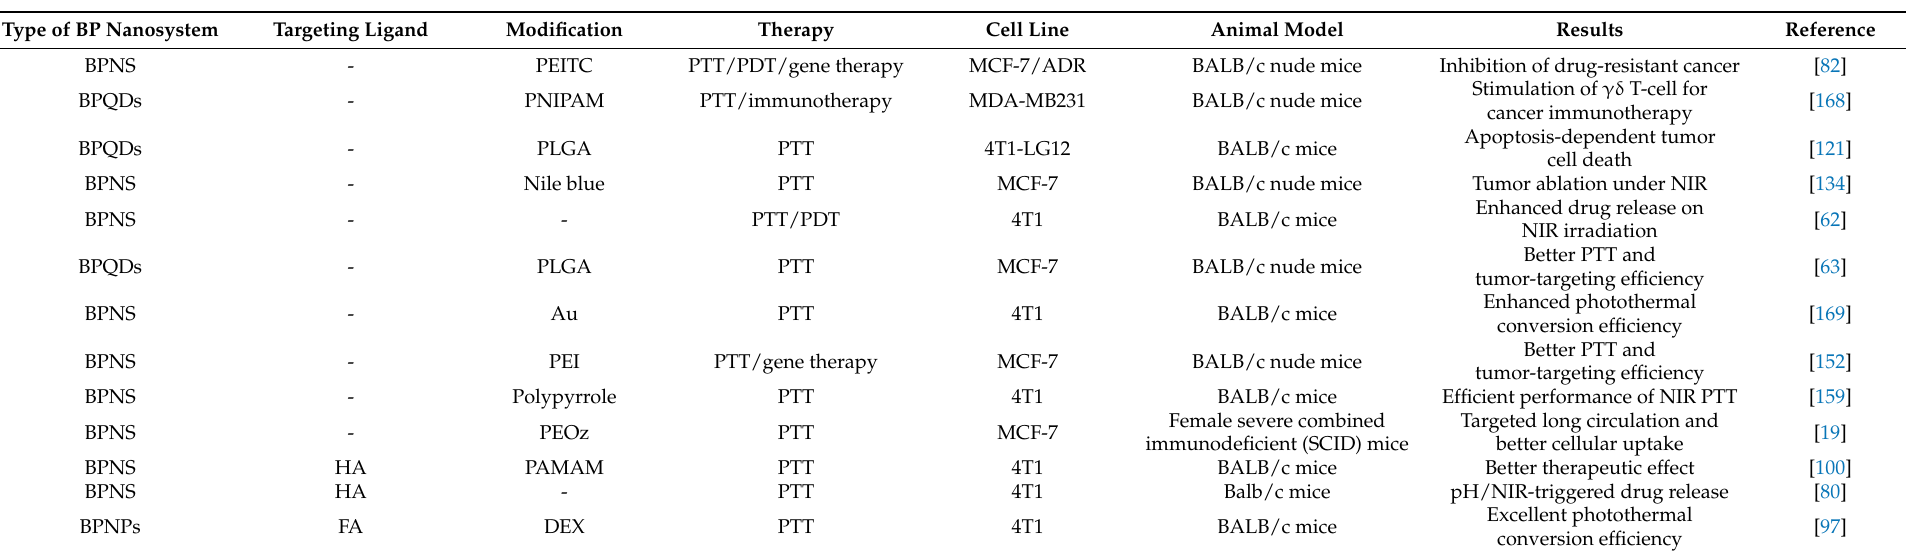
Table 2. Applications of BP nanomaterials in